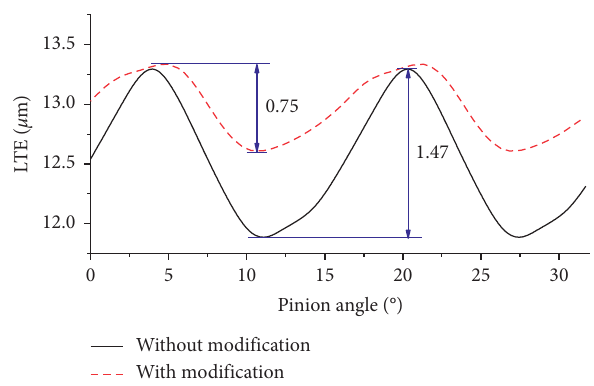
Figure 26: LTE of input-stage gear pair with and without modification.